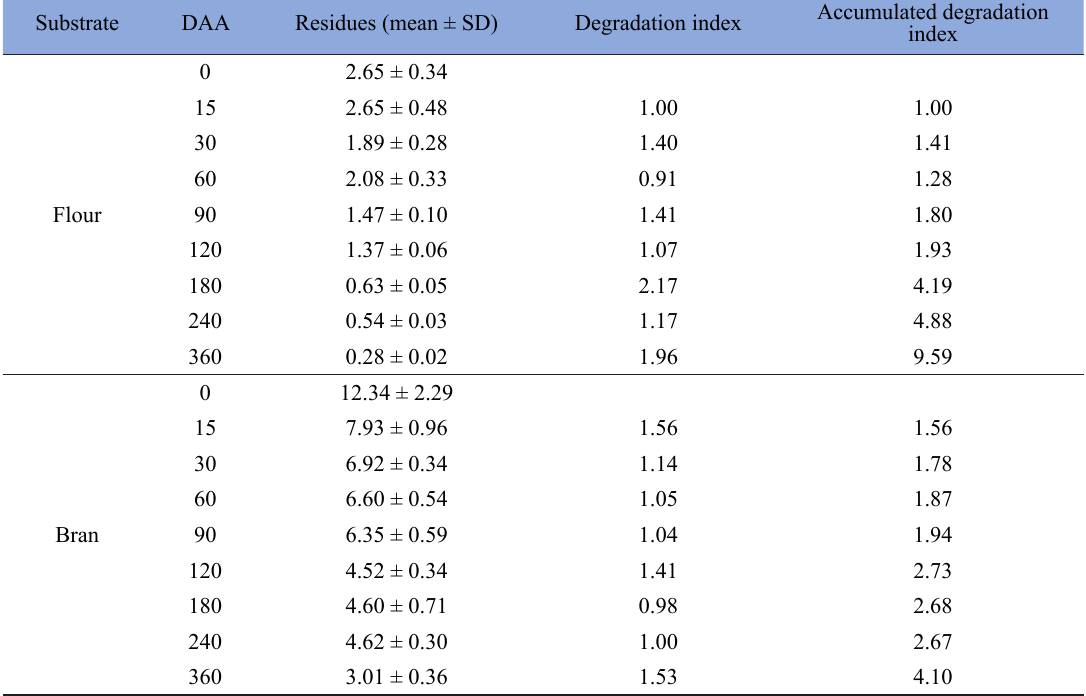
Table 4. Fenitrothion residues (mg kg −1 ) in wheat flour and bran. Substrate